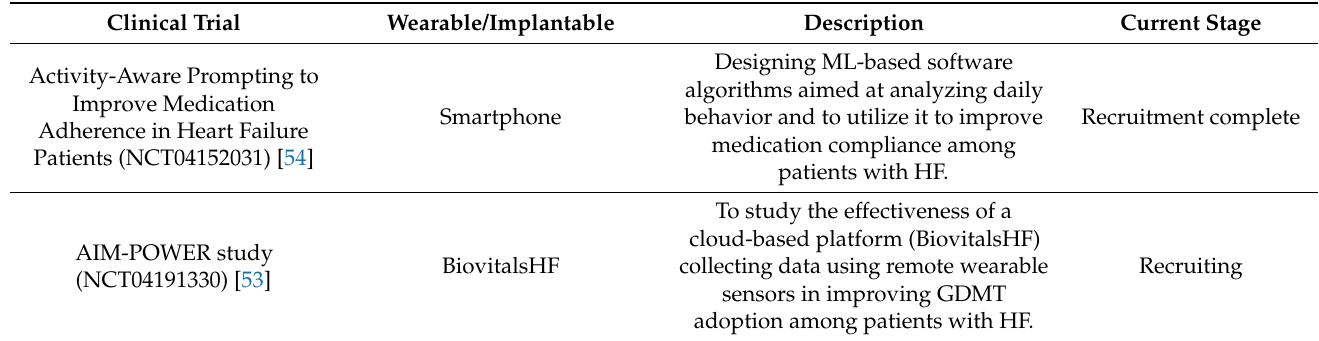
Table 3. Ongoing clinical trials investigating the application of digital devices and machine learning in HF